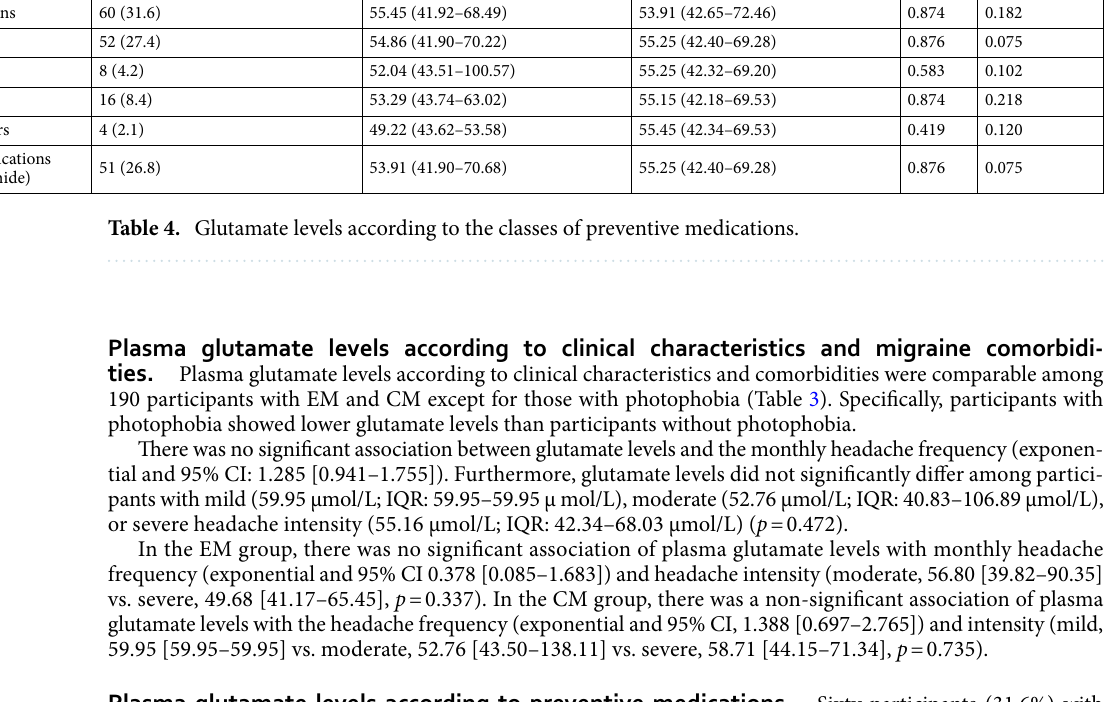
Number of participants using the corresponding class of preventive medications, N (%)